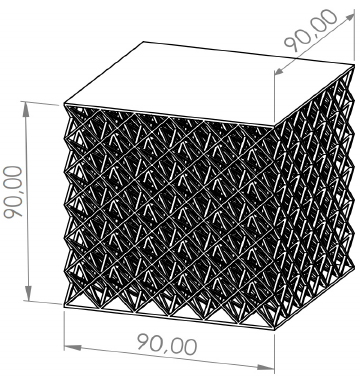
Figure 1. Lattice structure dimensions (mm).